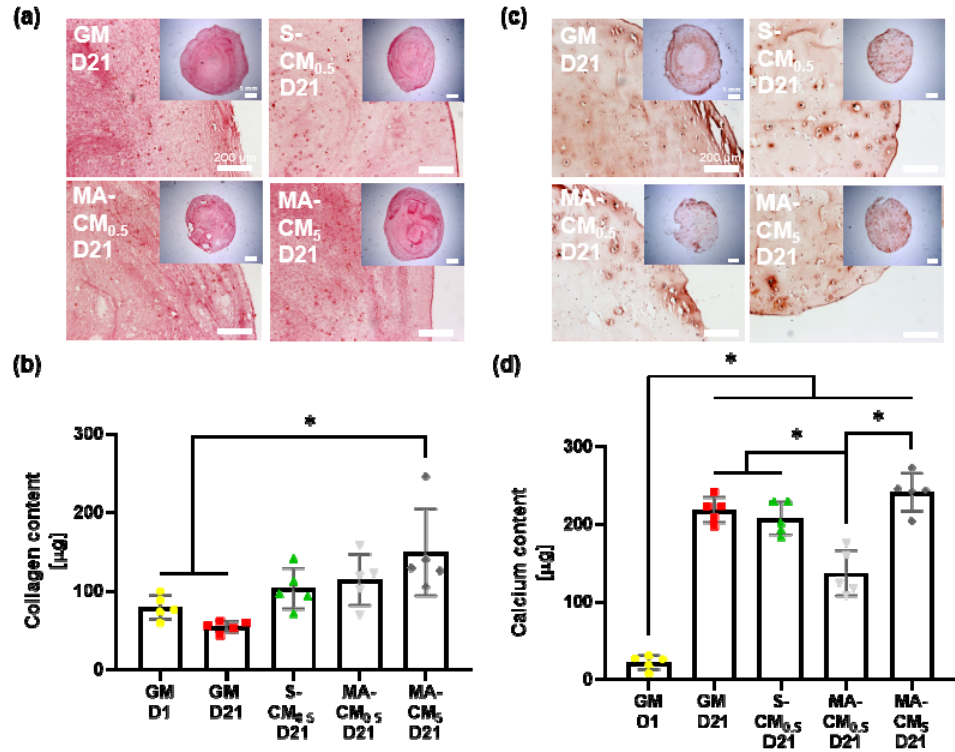
Figure 5. IPN hydrogels functionalized with osteocyte derived biochemical factors enhance hMSC osteogenic matrix deposition. ( a ) Collagen production qualified through picrosirius red staining for the different media groups supplemented with 10% FBS and osteogenic factors including growth media GM D1 and GM D21, osteocyte conditioned medium at 0.5 mg/mL quantified at day 21 after hMSC incorporation (S-CM 0.5 D21), mechanically activated osteocyte conditioned medium at 0.5 mg/mL and 5 mg/mL quantified at day 21 after hMSC incorporation (MA-CM 0.5 D21 and MA-CM 5 D21) (scale bar: 200 μ m, scale bar inset: 1 mm); ( b ) collagen content quantified with a hydroxyproline assay for every medium group (n = 5); ( c ) mineral production qualified through alizarin red staining for the different media groups (scale bar: 200 μ m, scale bar inset: 1 mm); ( d ) mineral content quantified with a calcium assay for every medium group (n = 5).